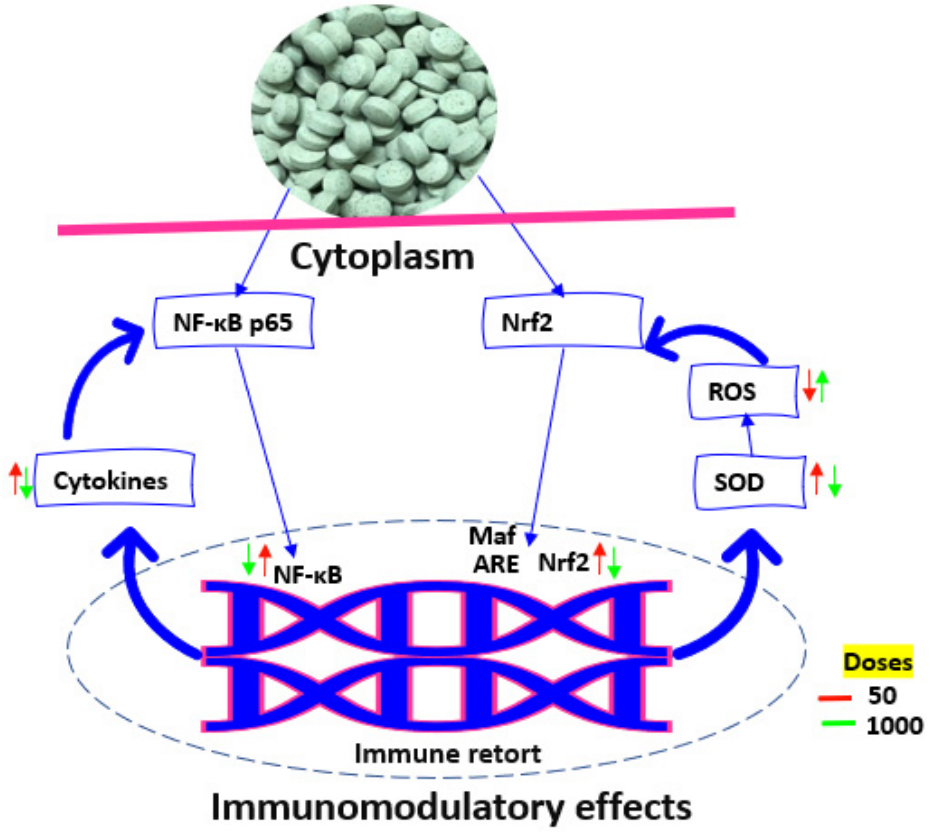
Figure 6. Representative diagram of the potential immunomodulatory effects of date seed pills on the RAW264.7 macrophages facilitated by impacts on nuclear NF- κ B and Nrf2 translocation.